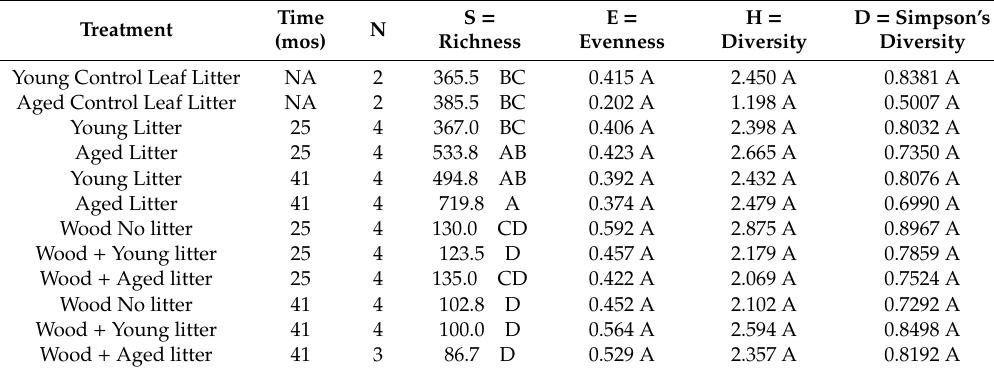
Table 4. Results of richness analysis. Statistical significance of each richness variable is included in the table, samples with same letter are not significantly di ff erent, while those designated with di ff erent letters were deemed significant ( p =